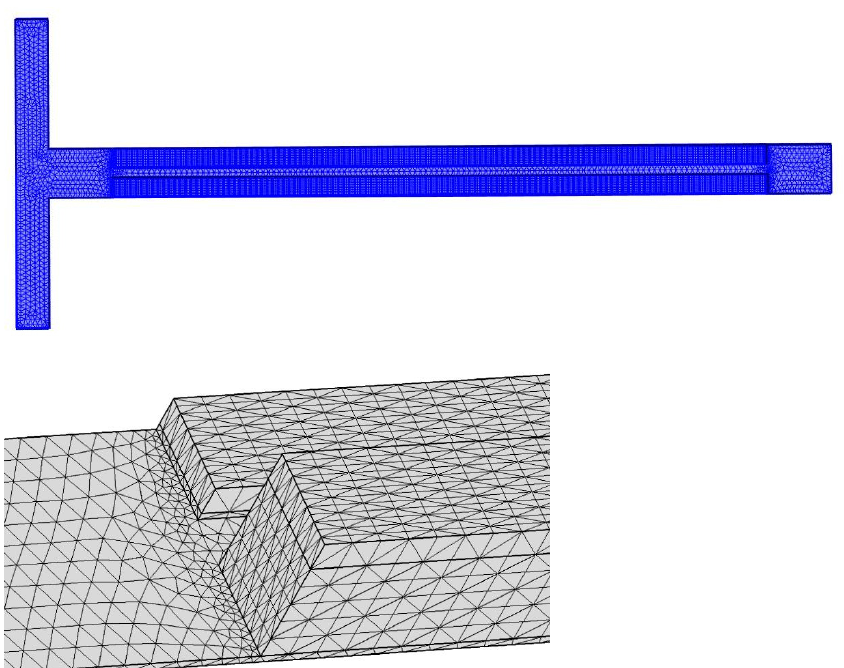
Figure 2. The mesh of the microfluidic fuel cell model.